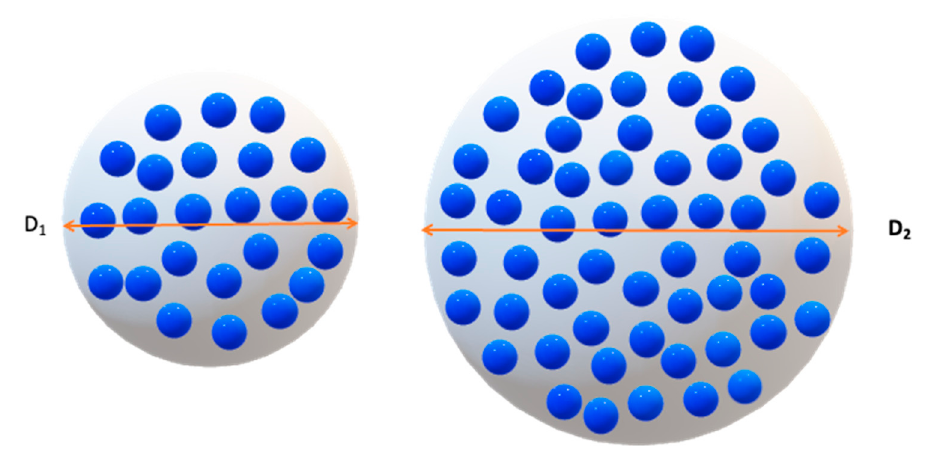
Figure 3. Increase of the particle size (white shape) with increase of the number of atoms included in the particle (blue circles), with D 1 < D 2 .